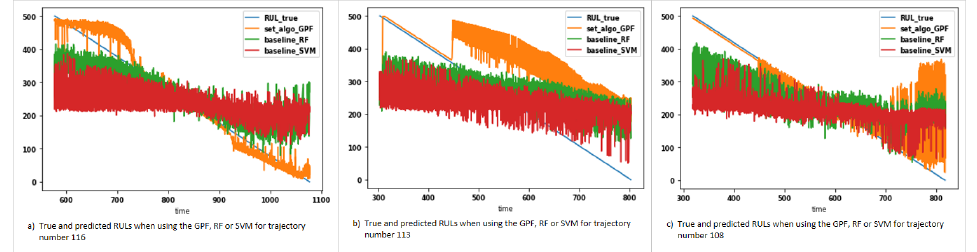
Figure 19. True and predicted values for three different trajectories of the SCU test set when using the GPF, RF, and SVM (cut 50 FC before